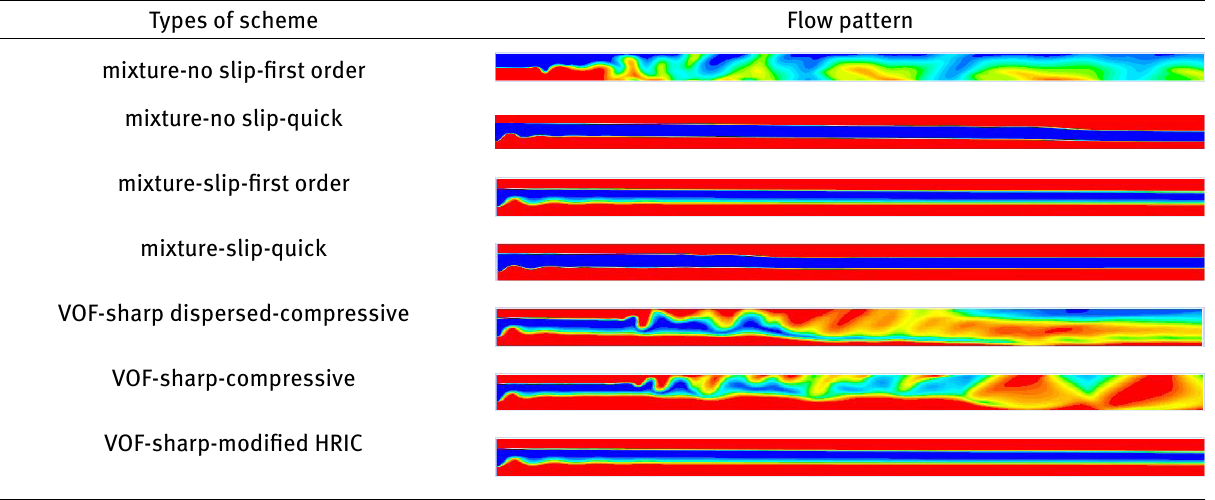
Table 11: Inlet the kerosene from the middle for two-phase flow patterns, (L = 2 m, H = 10 cm), mesh (780,000)